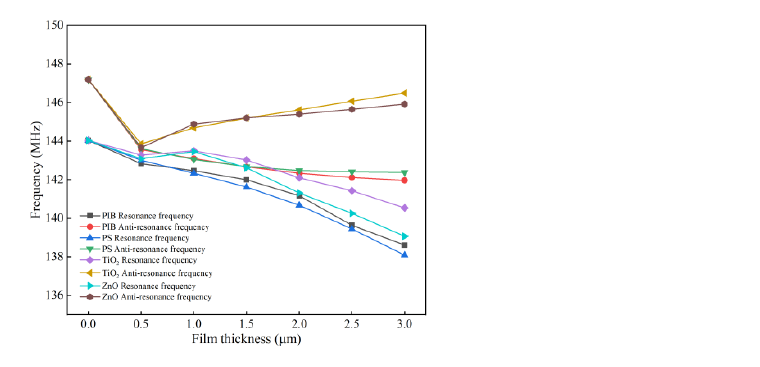
Figure 9. Thickness-frequency variation characteristics of different sensitive Figure 9. Thickness ‐ frequency variation characteristics of different sensitive films.